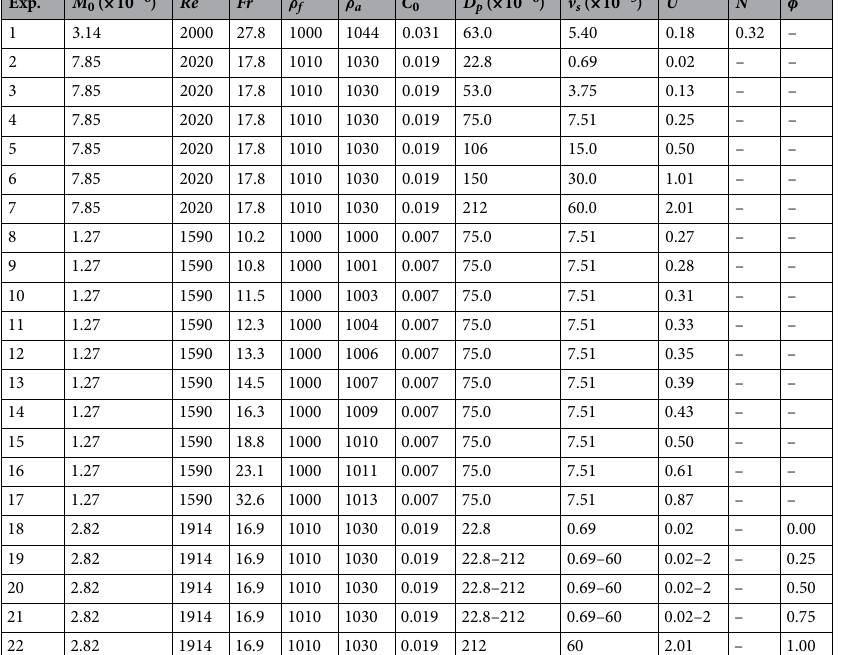
Table 1. Experimental parameters for particle fountains. M 0 ( m 4 s − 2 ) is the source momentum flux, Re is the source Reynolds number, Fr is the source Froude Number, ρ f is the density of the fountain fluid ( kg m − 3 ), ρ a is the density of the ambient fluid at the base of the tank ( kg m − 3 ), C 0 is the initial concentration of particles in the fountain mixture, D p (m) is the particle diameter, v s ( ms − 1 ) is the particle sedimentation speed, U is the dimensionless particle fall speed, N ( s − 1 ) is the Brunt-Väisälä buoyancy frequency and φ is the fraction of particles with U > 1